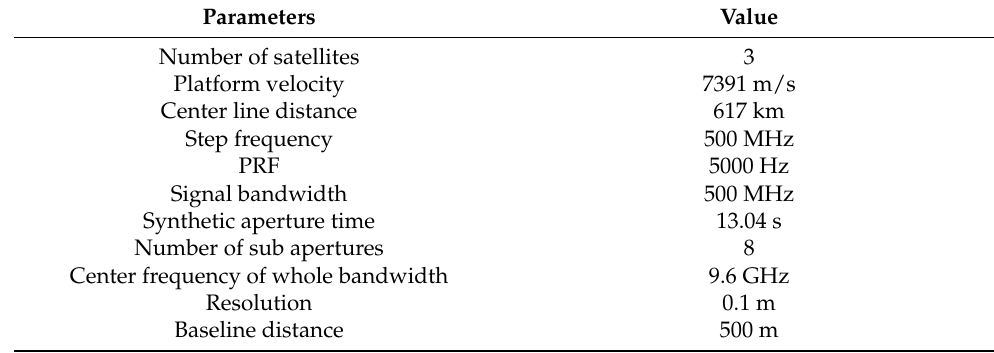
Table 1. Simulation